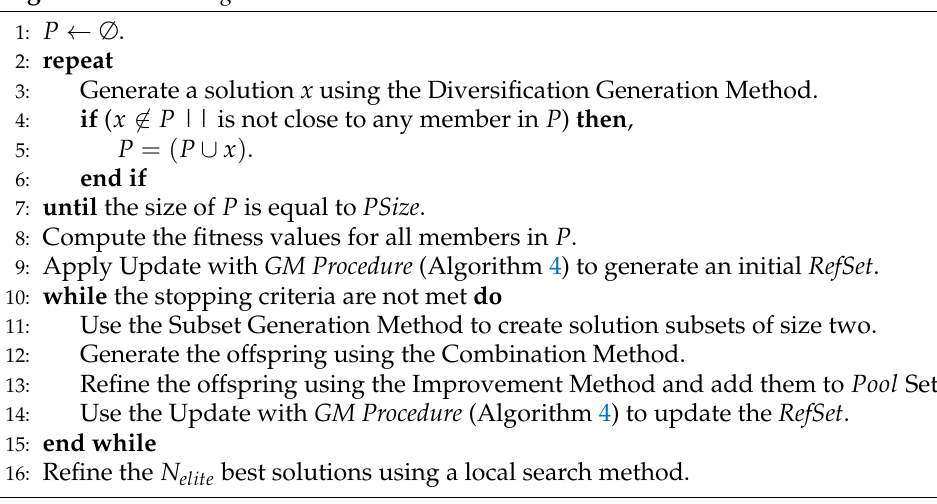
Algorithm 5 DSS Algorithm